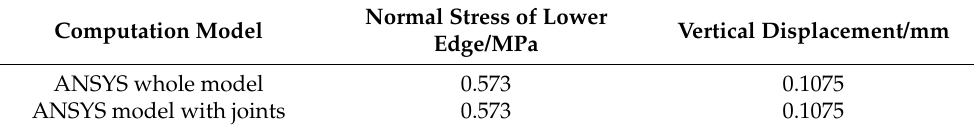
Table 2. Results at midspan of the girder specimen under self-weight.